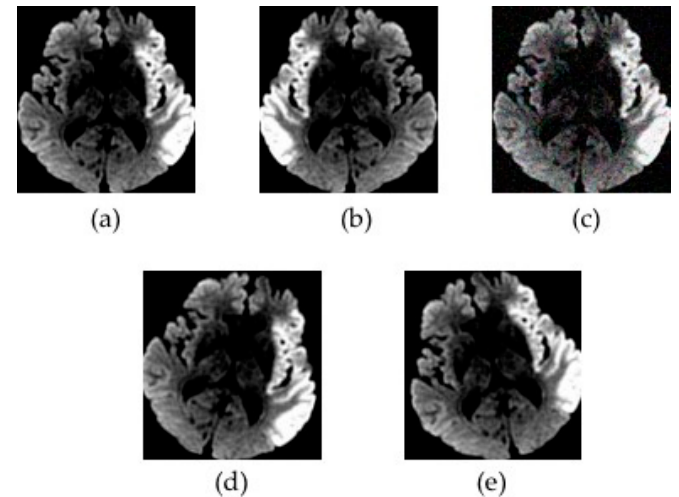
Figure 3. An illustration of data augmentation. The preprocessed diffusion-weighted magnetic resonance imaging data ( a ) underwent a horizontal flip ( b ), the addition of Gaussian noise ( c ), a clockwise 15-degree rotation ( d ), and a counter-clockwise 15-degree rotation ( e ).